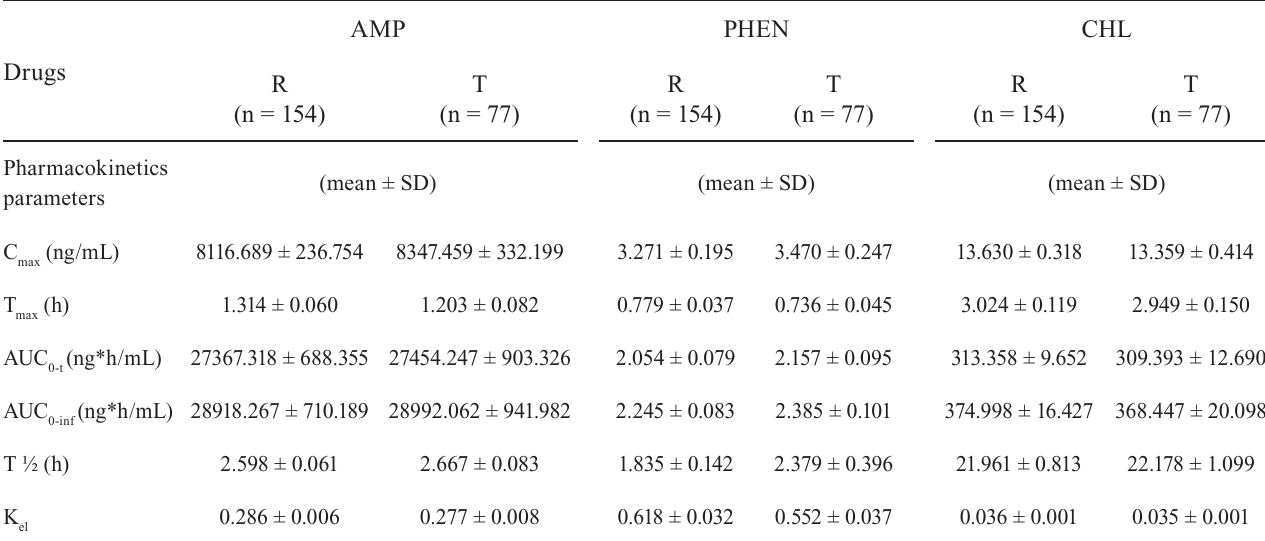
TABLE III - Pharmacokinetics parameters of acetaminophen, phenylephrine and chlorpheniramine after single dose in healthy volunteers (n = 77), concerning test/reference treatments